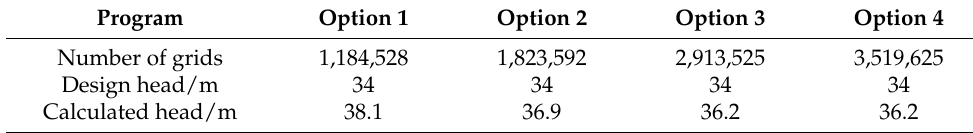
Table 1. Grid-independent verification.